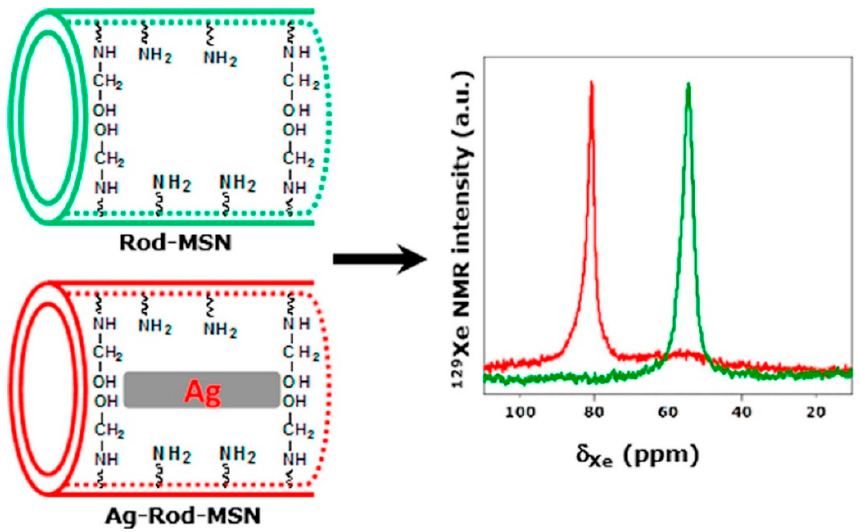
Figure 8. Comparison of the spectra of rod-shaped mesoporous silica particles and their correspond- ing Ag-loaded counterparts. Reprinted with permission from reference [102]. Copyright 2006 Journal of Solid State Chemistry .